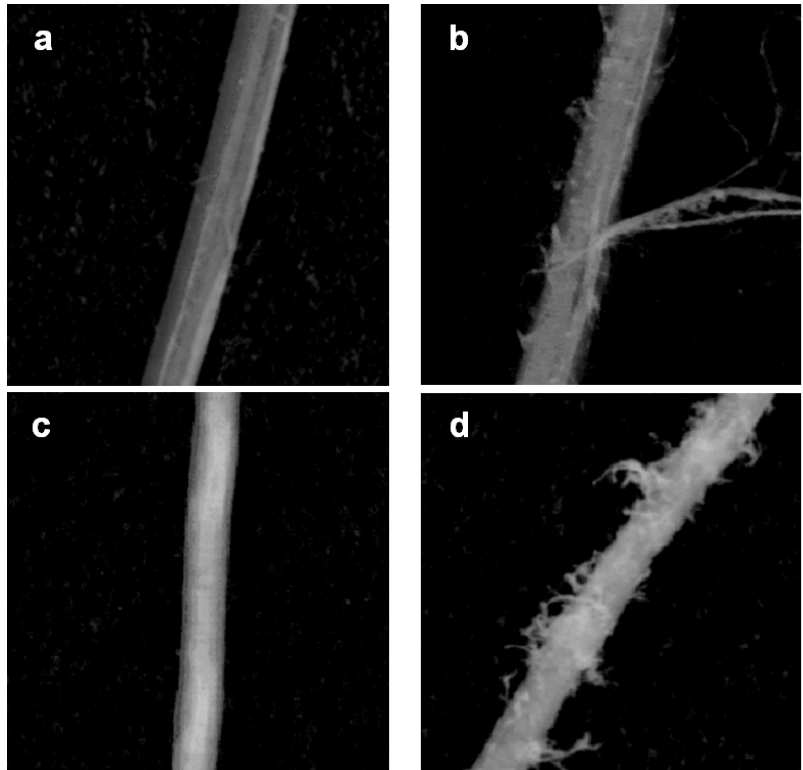
Figure 7- Magnified images: macrofibre A under normal conditions a); macrofibre A after mixing b); macrofibre B in normal conditions c); macrofibre B after mixing